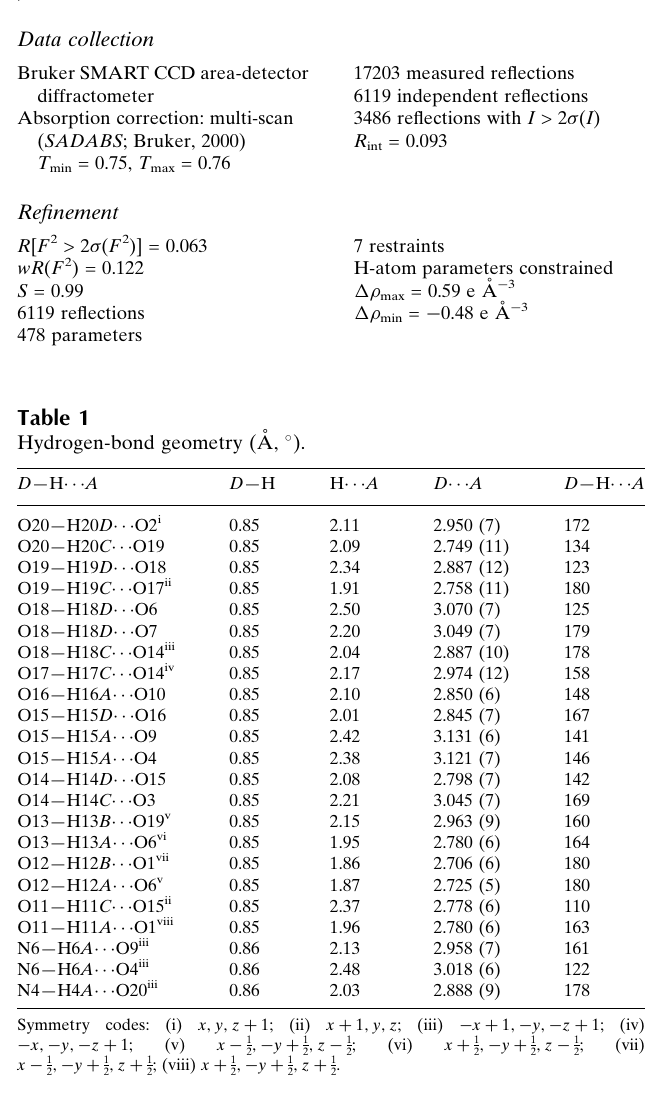
structure: SHELXTL ; molecular graphics: SHELXTL ; software used to prepare material for publication: publCIF (Westrip,